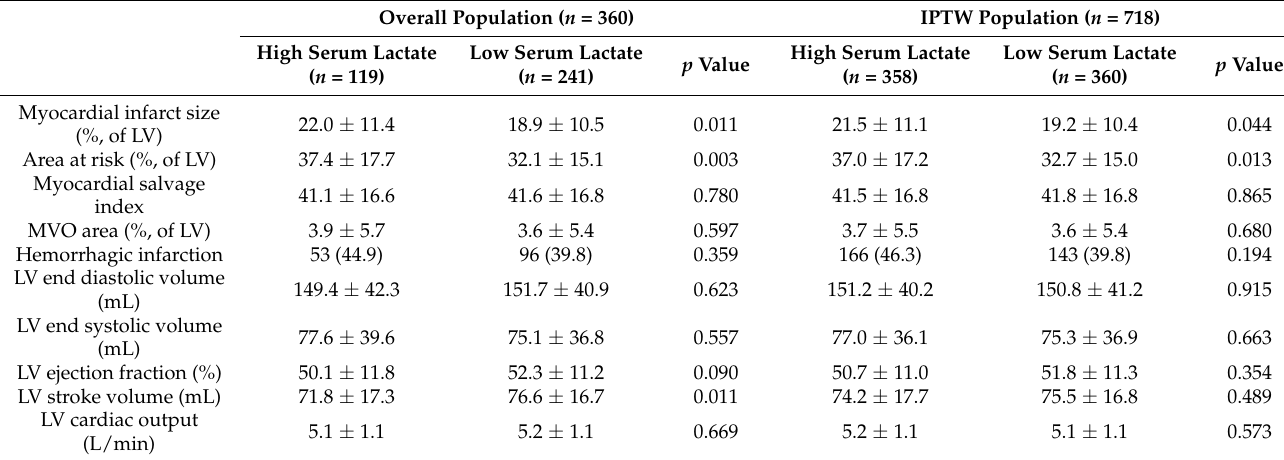
Table 3. Analysis of cardiac magnetic resonance findings.